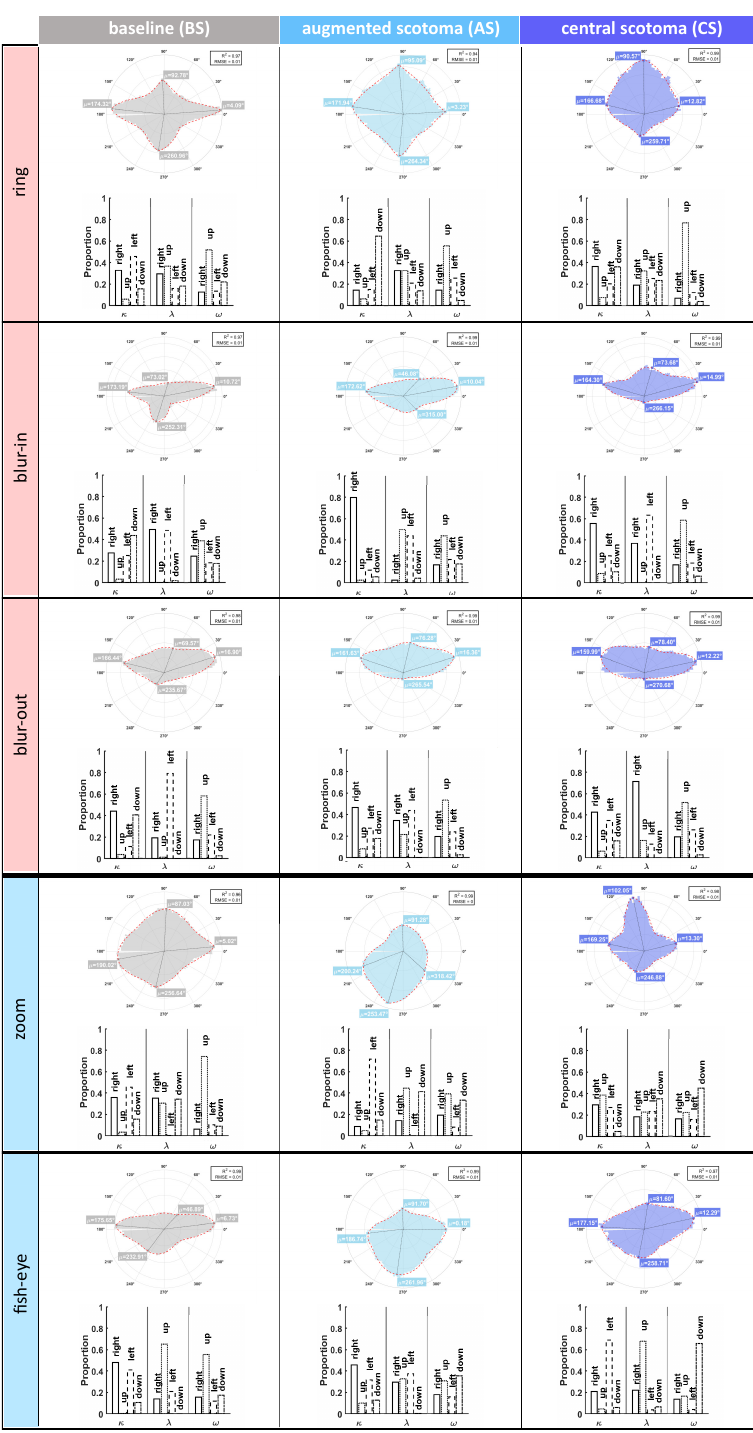
Figure 5. Polar histograms of gaze direction in respect to the target for all the five augmentations (cued monocular, red, and optical distortions binocular, blue) were tested across the three conditions (baseline, augmented scotoma, and central scotoma). The red dotted line represents the outcome of the fitted non-linear square model, with the R-squared and RMSE values plotted above each polar histogram. Additionally, the µ values for the right, up, left, and down directions are plotted. Beneath all polar histograms, an additional histogram representing the κ , λ , and ω parameters for each directionality is also